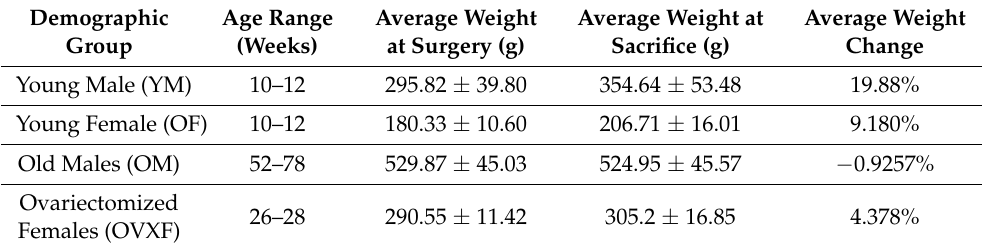
Table 1. Demographic details of Lewis rats used in this study.